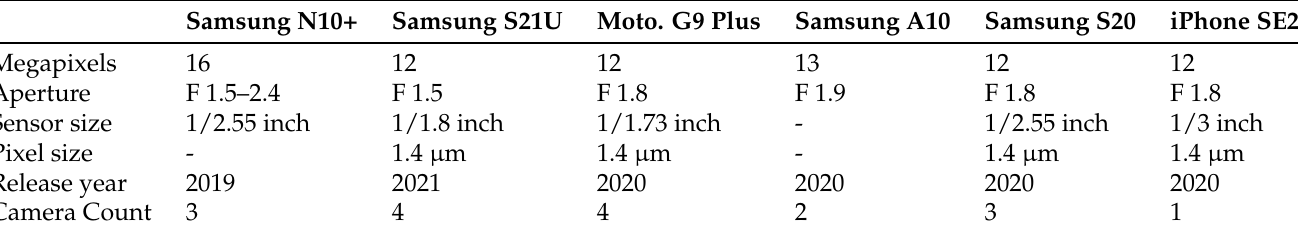
Table 1. Summary of devices camera